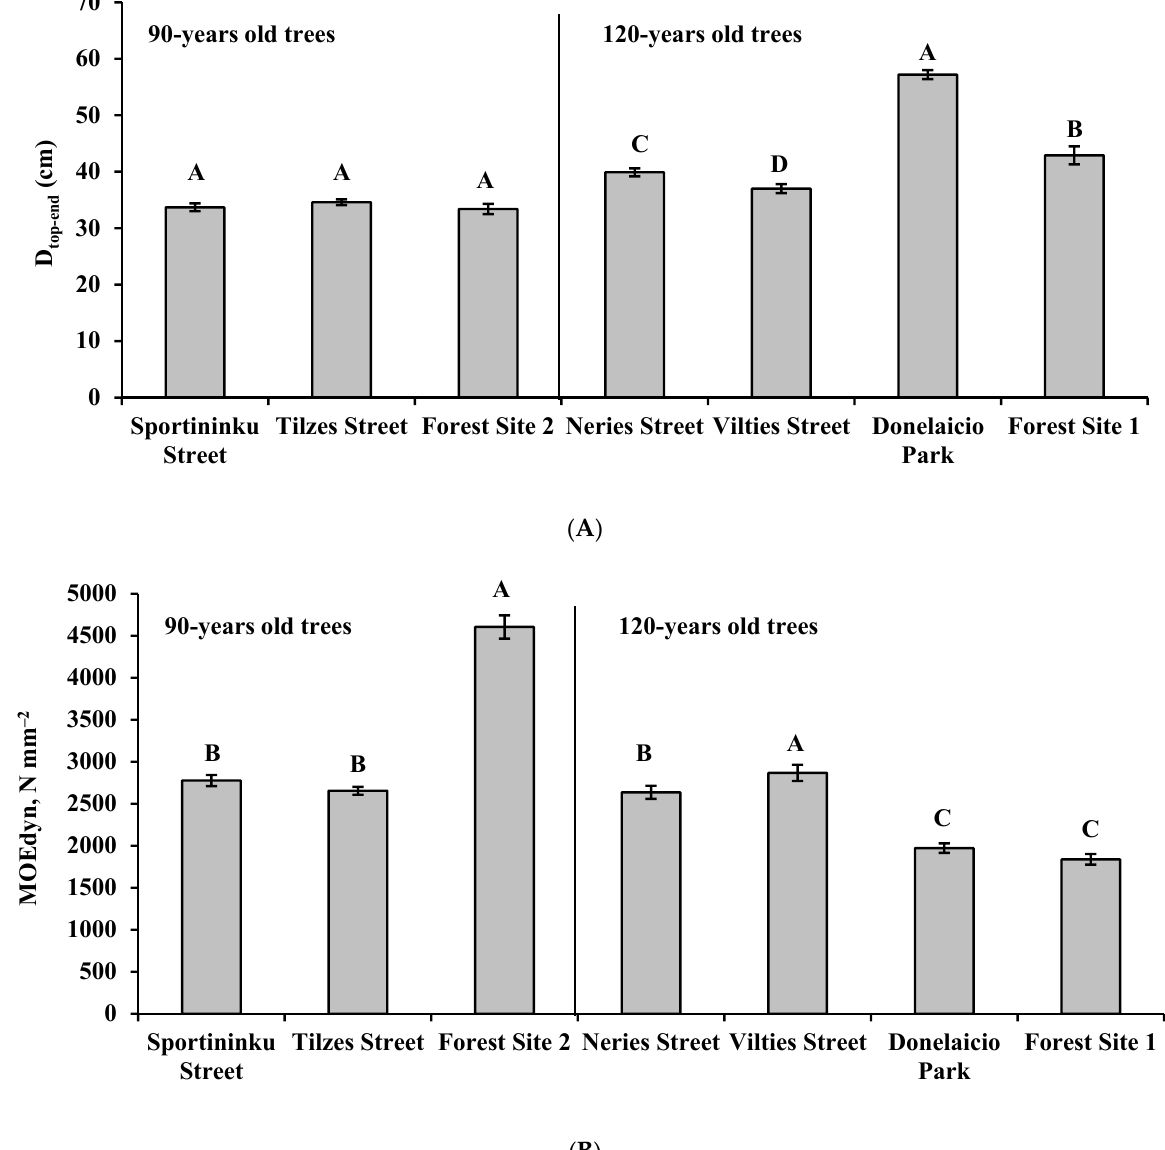
Figure 4. Mean values of top-end diameter (D top-end , cm) ( A ), and dynamic modulus of elasticity (MOEdyn, N mm − 2 ) ( B ) of small-leaved lime trees from different sites. Bars show the standard error of the mean. Different capital letters at the top of the columns show statistically significant differences between the sites within each tree age group (separately for 90- and 120-year old trees) at p <